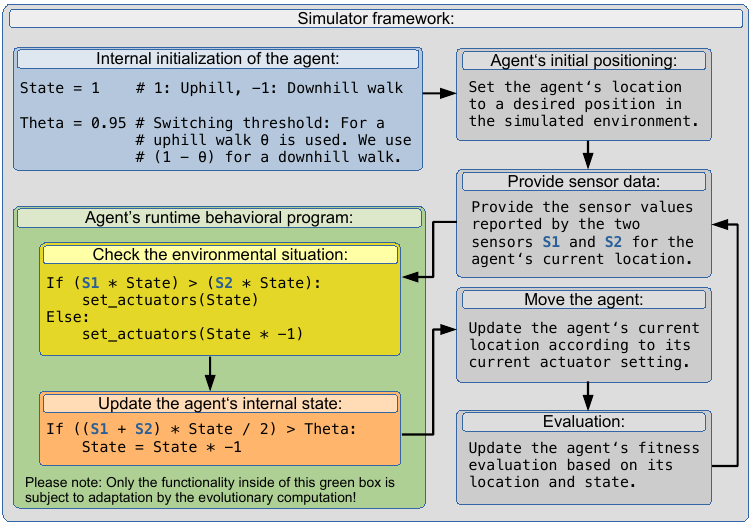
Figure 2. The functionality of the basic simulation framework and Python-like pseudo-code of an optimal hand-coded controller for the Wankelmut behavior. Only the content of the green box is subject to the evolutionary process; the content of of the blue and gray boxes is provided by the simulation framework and by the initialization we provide in all examples analyzed here. This indicates that the task for the evolutionary algorithms basically is to create a functional surrogate of the few lines of code shown inside the yellow and orange